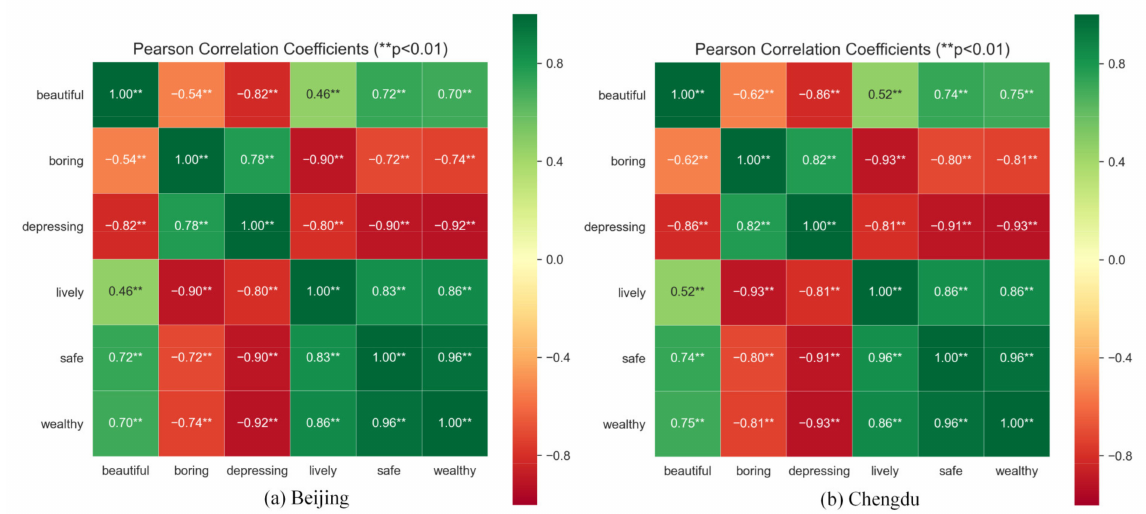
Figure 11. Pearson correlation matrix among the six perceptions using data from Beijing and